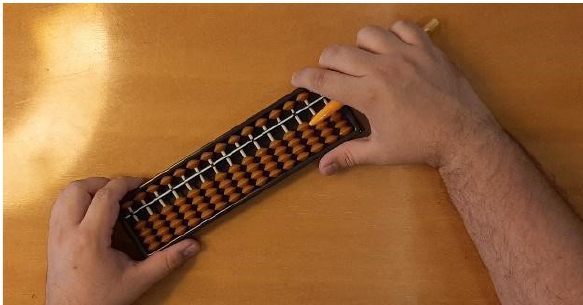
Figure 2. Image of a person using the physical abacus, provided by the Instituto Supera de Educação,